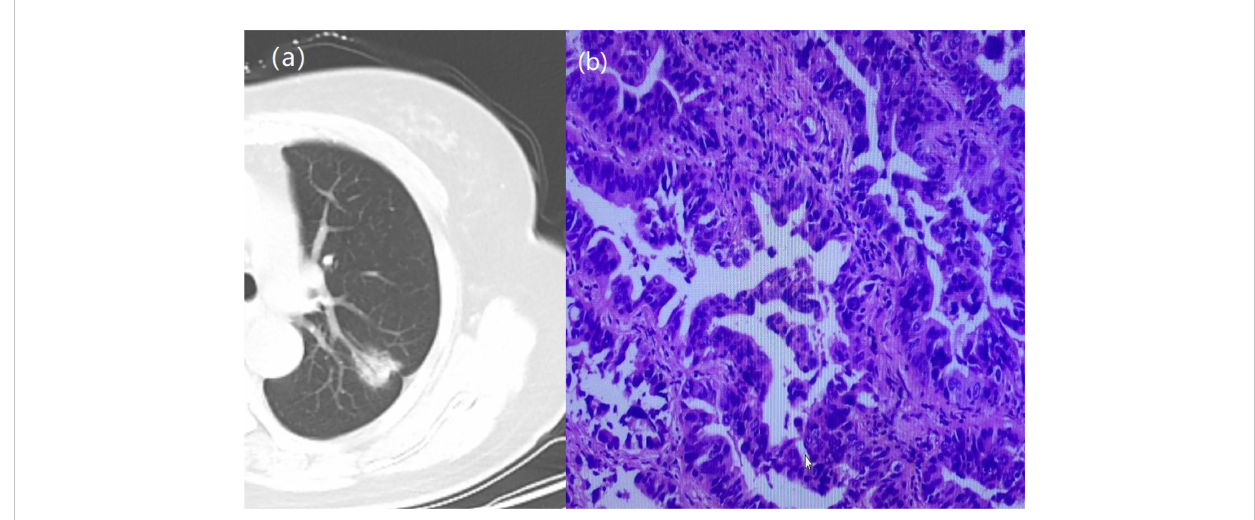
FIGURE 1 A 64-year-old woman with a GGN. CT showed lobulation, pleural traction, burr, bronchial signs. (A) Chest scan. (B) pathologically con fi rmed for